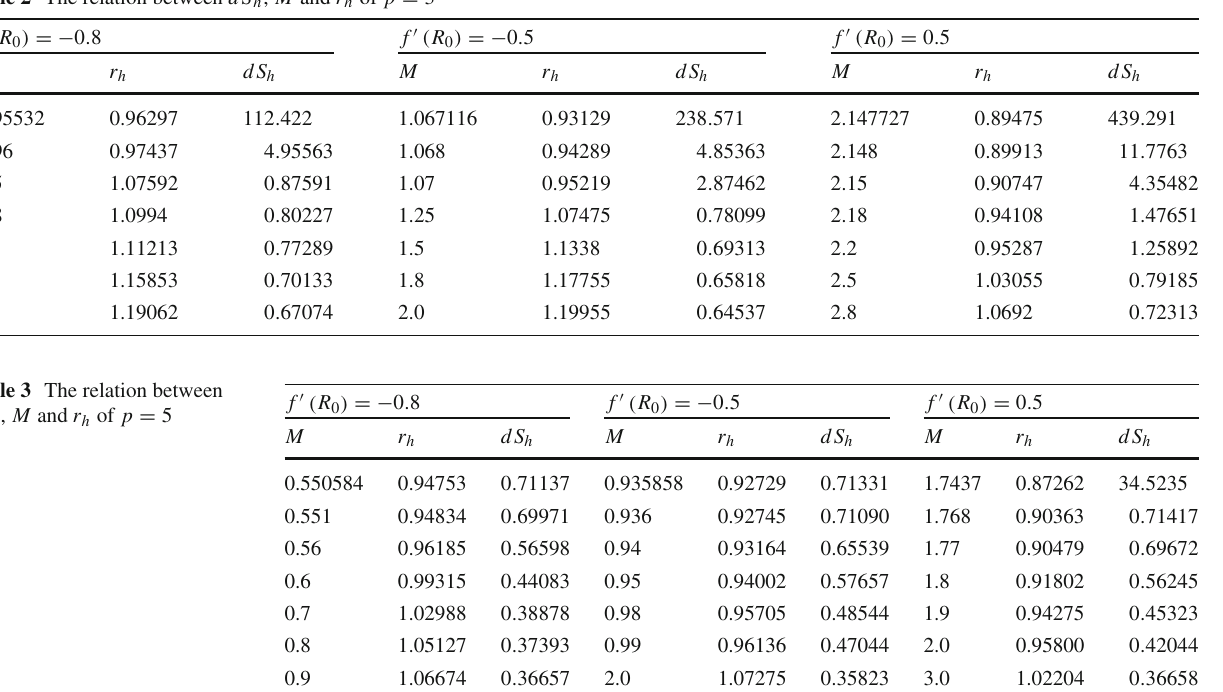
Table 2 The relation between dS h , M and r h of p = 3